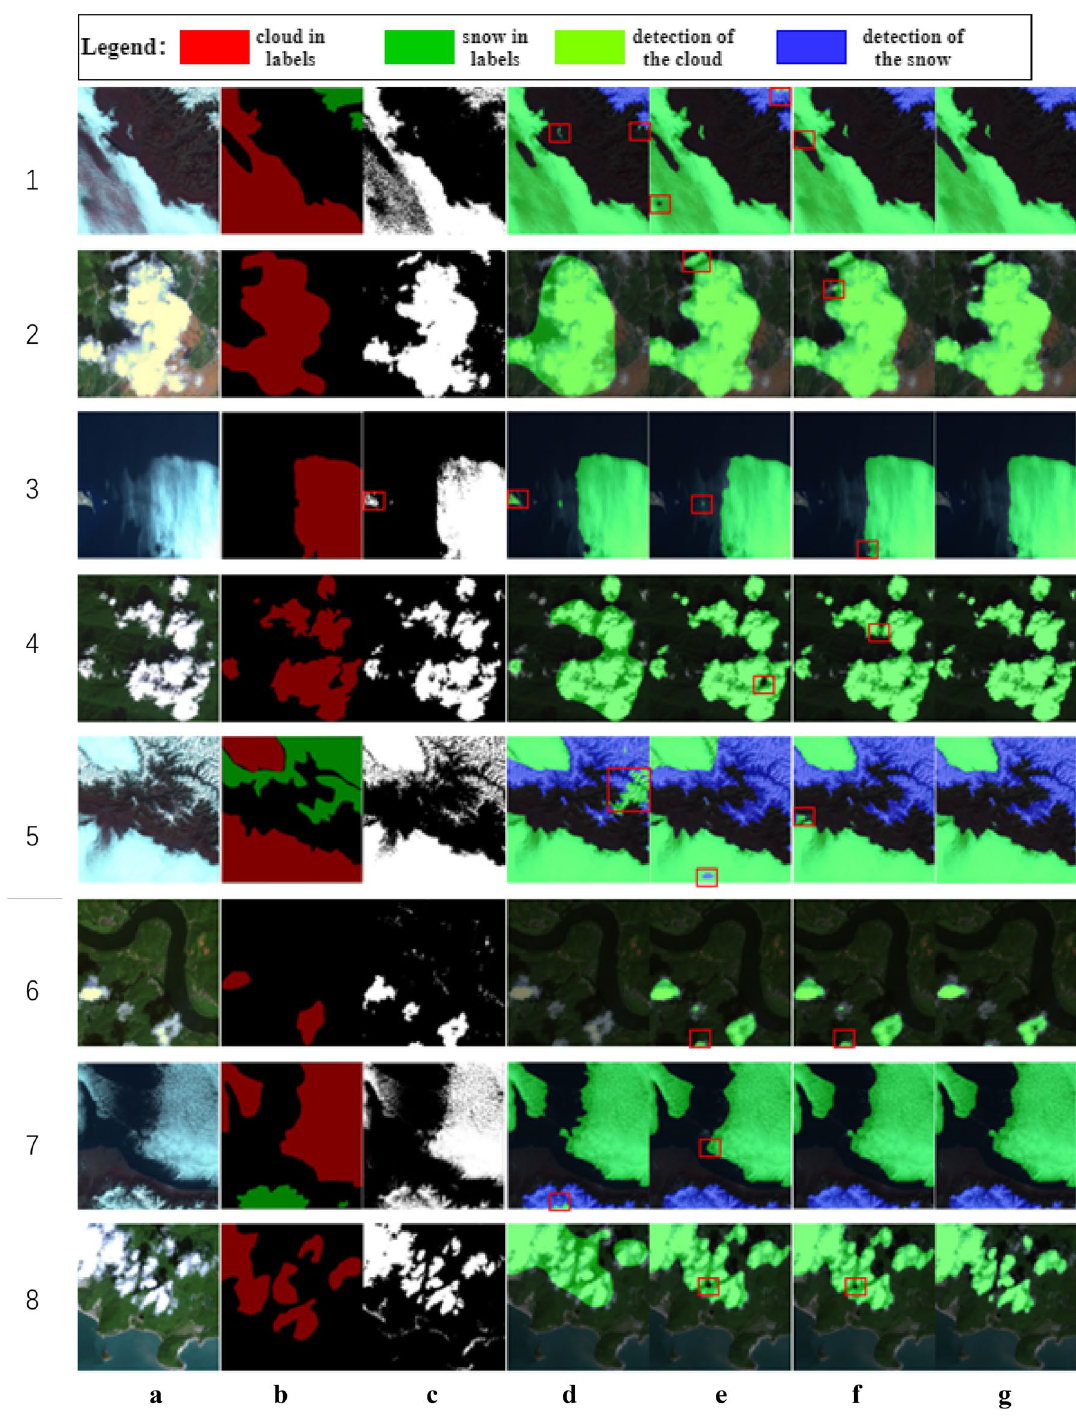
Figure 13. Prediction results ( a ) Original images; ( b ) Label images; ( c ) OTSU; ( d ) Unet; ( e ) Deeplabv3+; ( f ) CDUnet; ( g )